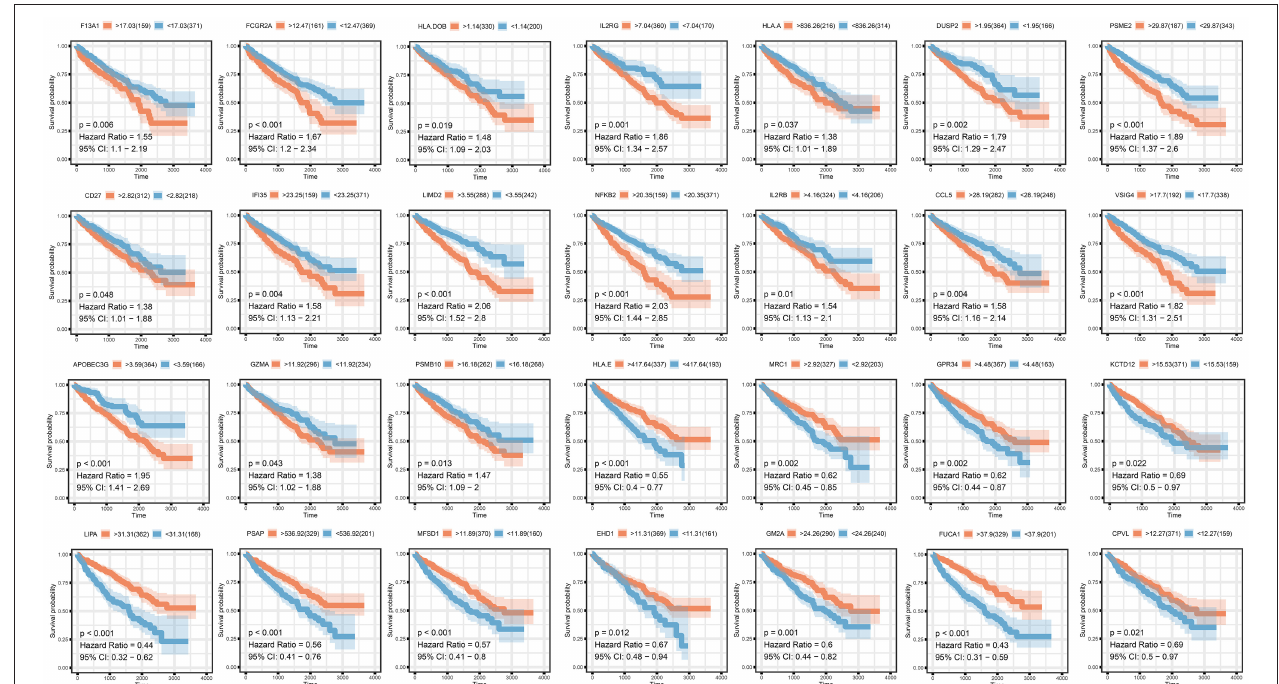
FIGURE 4 | Survival analysis of selected co-expressed genes in purple and pink